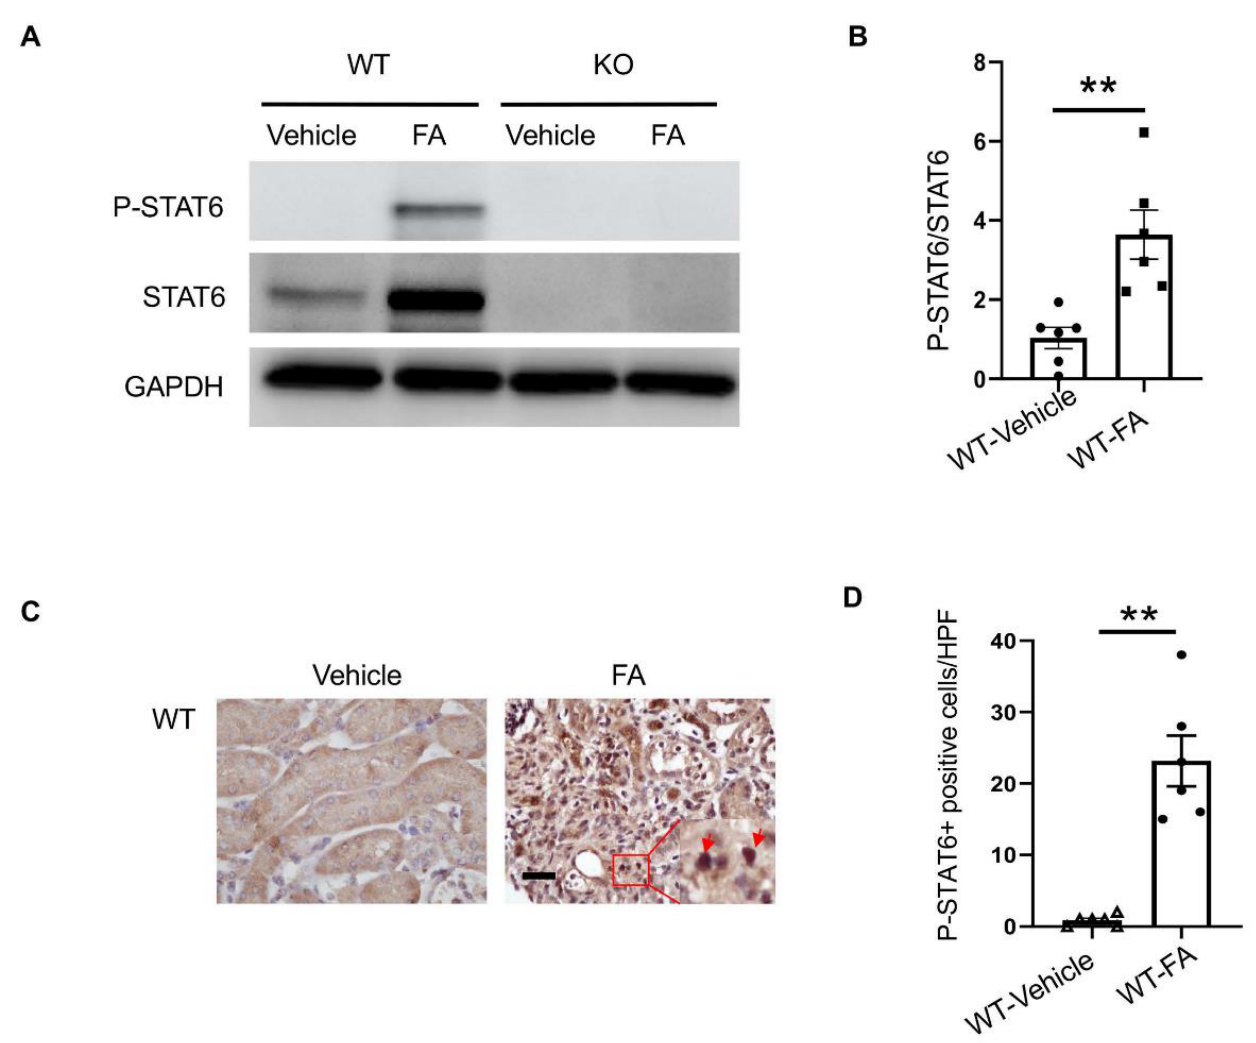
Figure 1. STAT6 is activated in the kidney with folic acid nephropathy. ( A ) Representative Western blots show protein levels of p-STAT6 and STAT6 in the kidneys. ( B ) Quantitative analysis of p-STAT6 in kidneys. ** p < 0.01. n = 6 per group. ( C ) Representative photomicrographs of kidney sections immunostained for STAT6 phosphorylation (brown) and counterstained with hematoxylin (blue). Scale bar, 50 µ m. ( D ) Quantitative analysis of phosphorylated STAT6-positive cells in kidneys. ** p < 0.01. n = 6 per group.